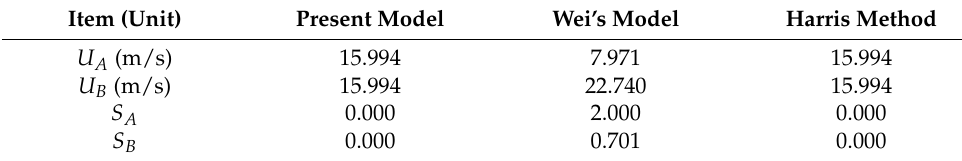
Table 1. Results using ball bearing